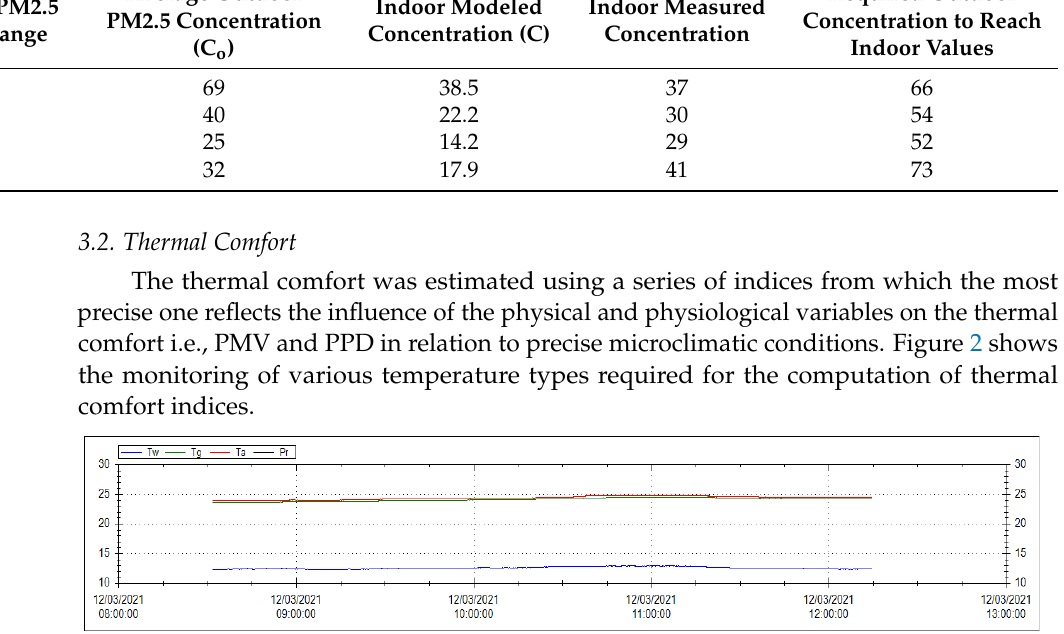
Table 4. Results of the mass balance approach to estimate the indoor concentrations of PM2.5 ( µ g m − 3 ). Monitored PM2.5 Group